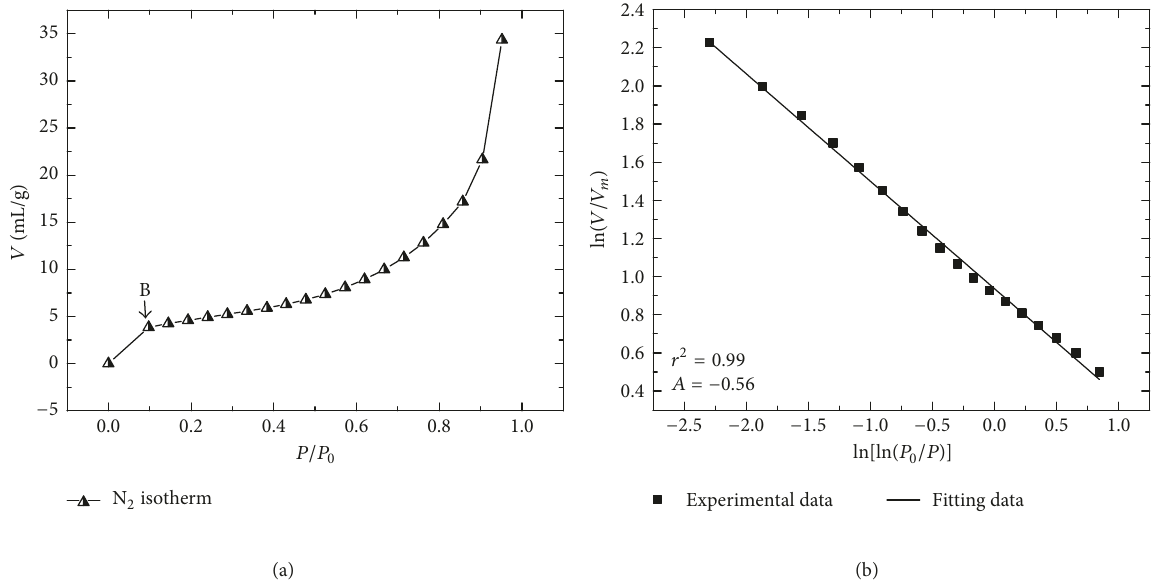
Figure 5: Adsorption isotherm of N 2 of the titanium pyrophosphate; (b) adjusted results of adsorption of the isotherm N 2 .